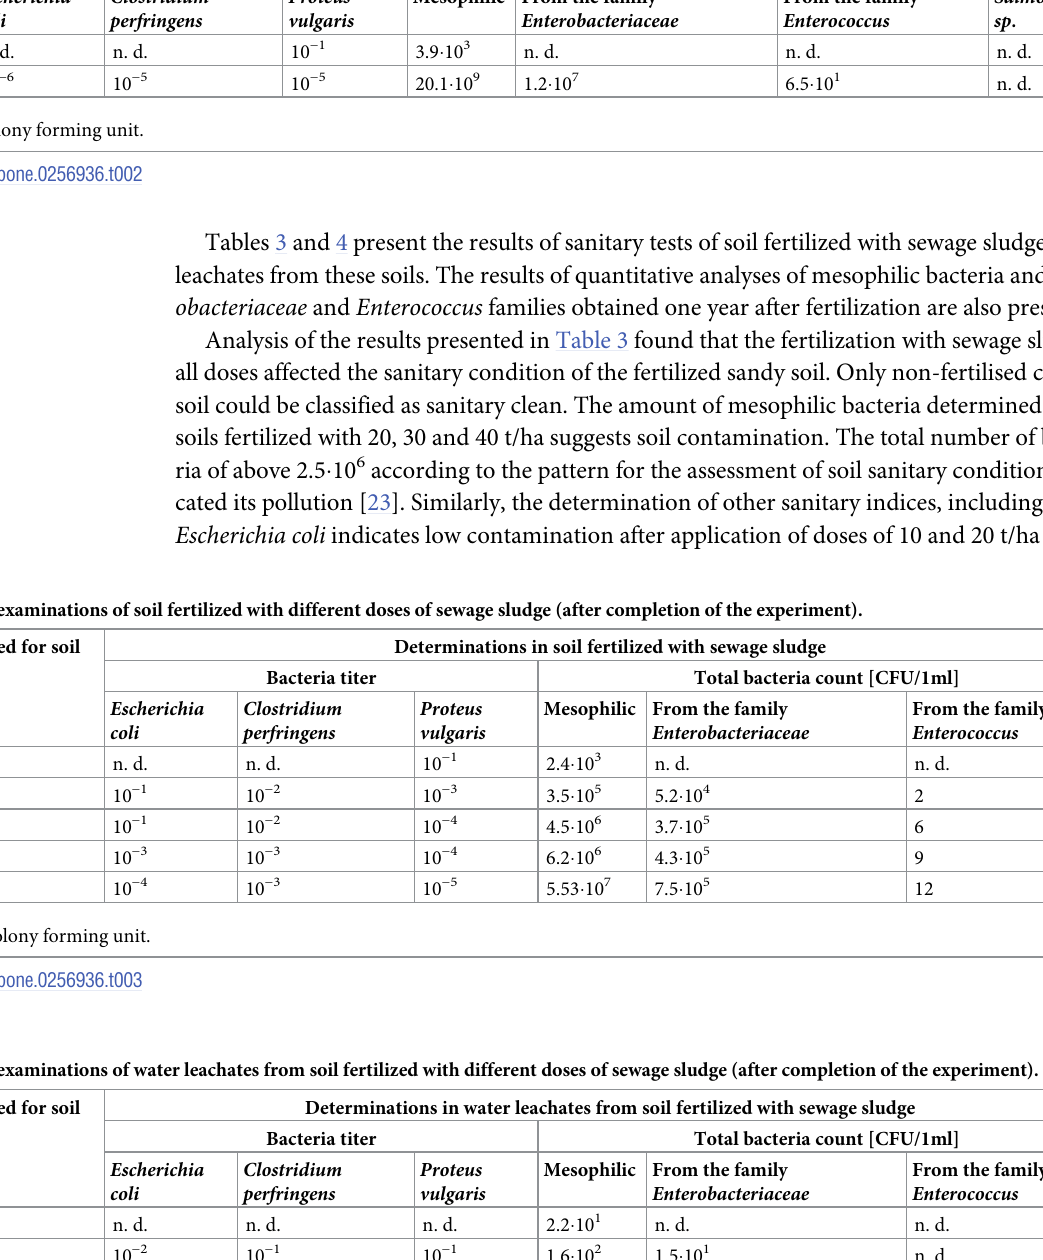
Table 2. Results of sanitary examinations of soil and sewage sludge used for the experiments. The type of material to be tested